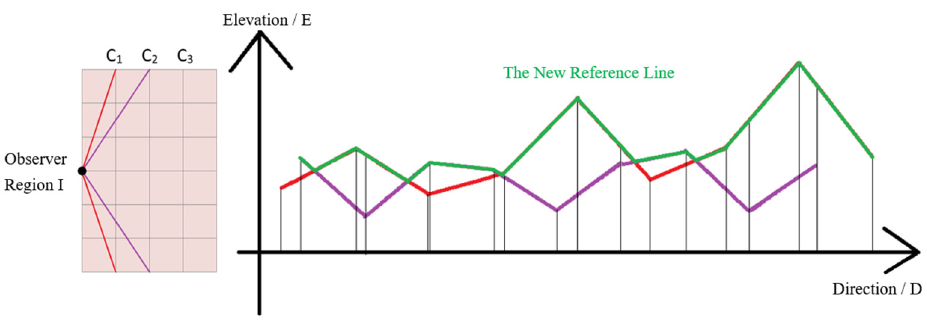
Figure 3. In the D-E coordinate system, while processing target points corresponding to line C 2 , line C 1 is the reference line, and line C 2 is the current line.